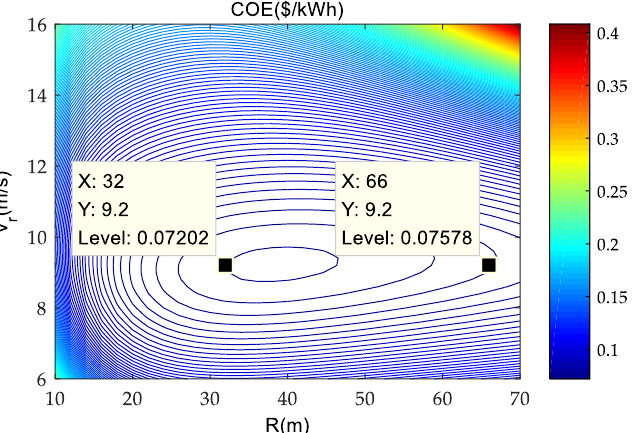
Figure 8. The offshore turbines COE versus the rotor radius and rated wind speed at a specific class m = 7m/s, k 0 = 3.6 and C p , eq = 0.42.